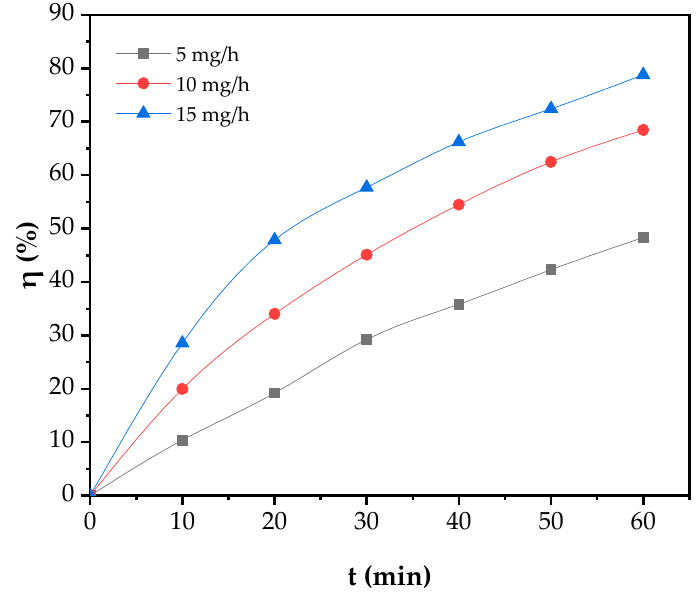
ff ect of ozone dosage on Cu removal e ffi ciency through a photochemical Figure 6. Effect of ozone dosage on Cu removal efficiency through a photochemical process. Figure 6. E